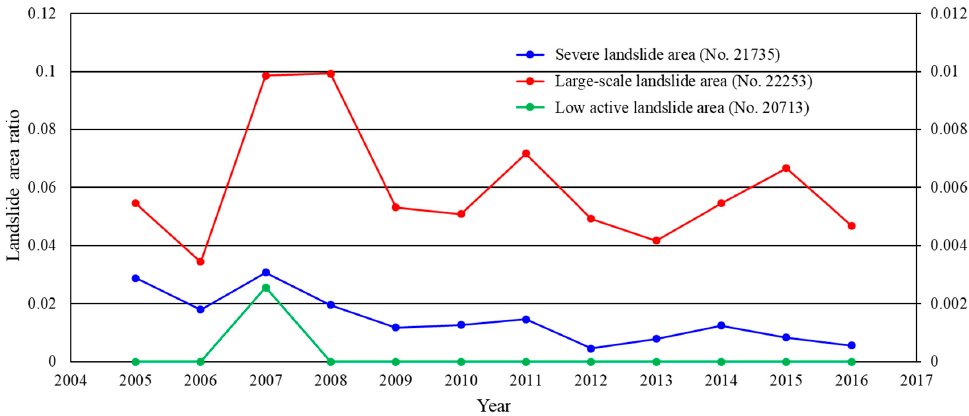
Figure 9. Landslide area ratio time series of the optimum sub-watersheds in a low active landslide area (No. 20713; green line; right y -axis), a severe landslide area (No. 21735; blue line; left-axis), and a large-scale landslide area (No. 22253; red line; left-axis).